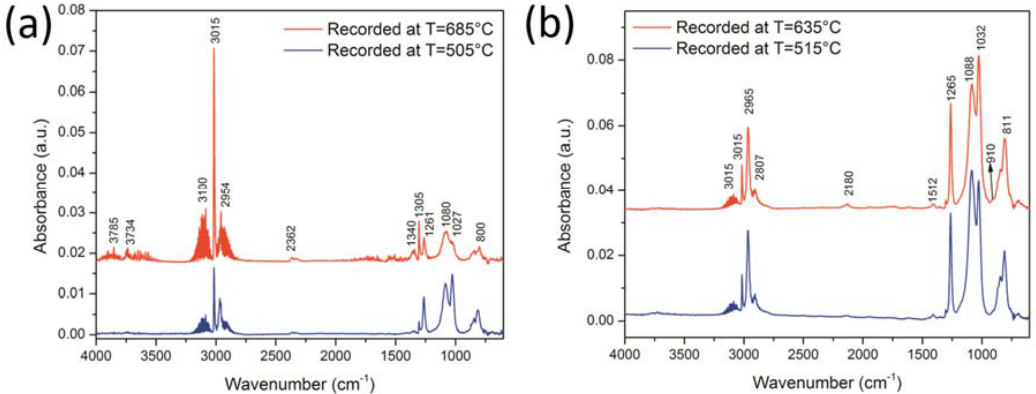
Figure 4. FTIR spectra of evolved gas from ( a ) bulk PDMS and ( b ) 3D porous PDMS foam recorded under N 2 flow at the two main thermal decomposition steps. Bulk PDMS and 3D porous PDMS foam samples correspond to the ethanol cleaning samples.